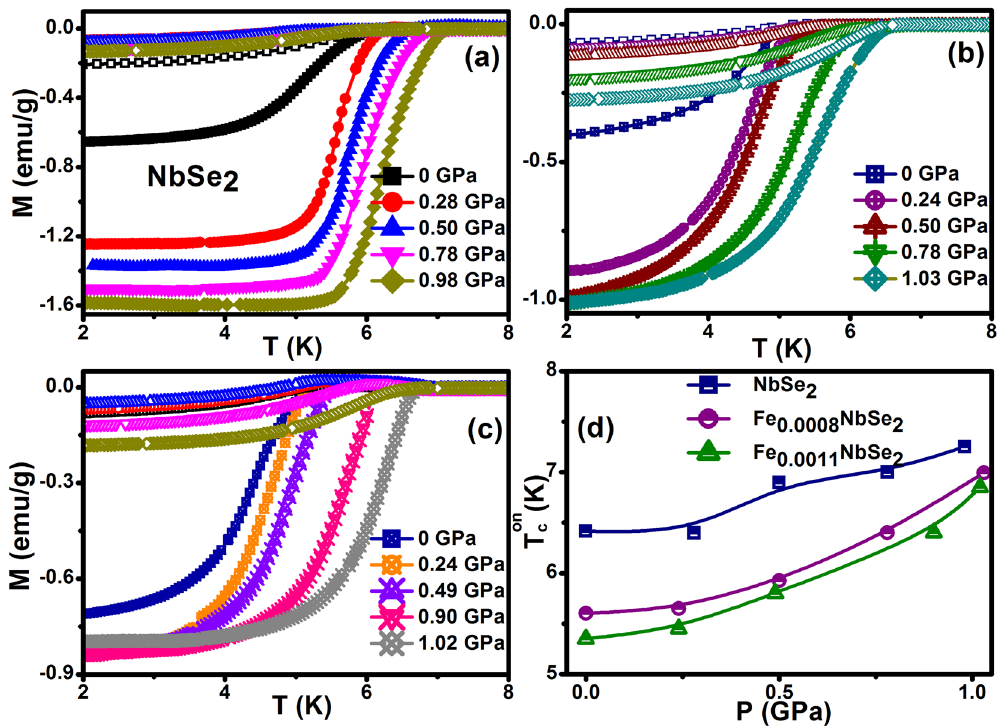
Figure 1. Temperature dependent zero-field cooling (ZFC) and field cooling (FC) magnetization measurements for ( a ) NbSe 2 ( b ) Fe 0.0008 NbSe 2 ( c ) Fe 0.0011 NbSe 2 at constant magnetic field 20